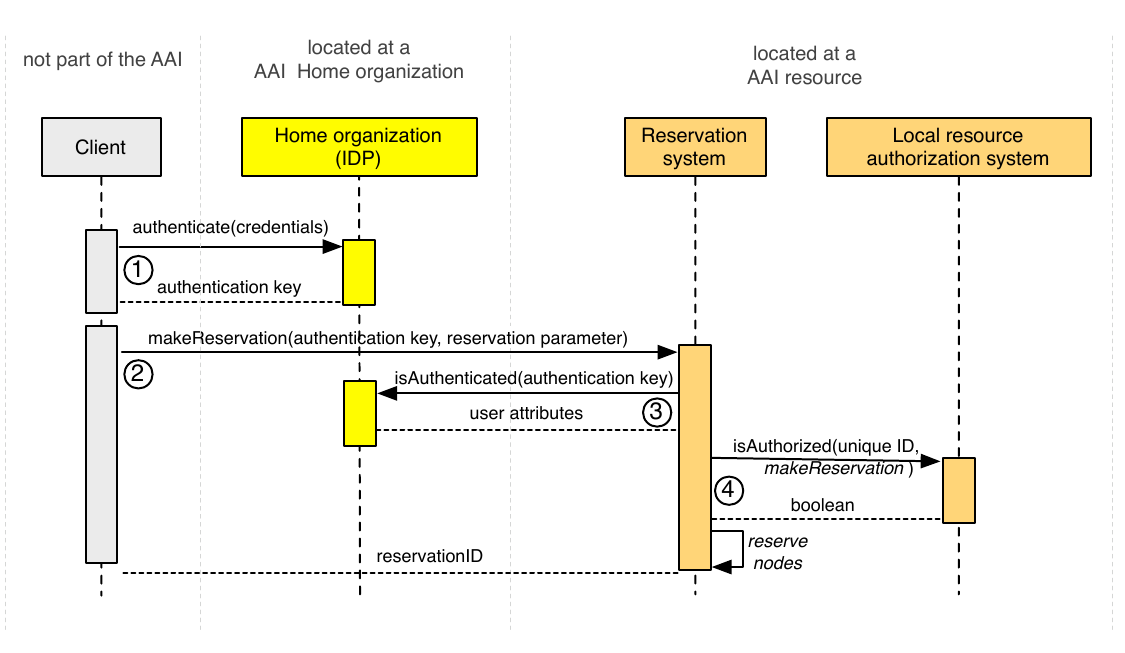
Figure 4. Sequence diagram of authentication and authorization of web service